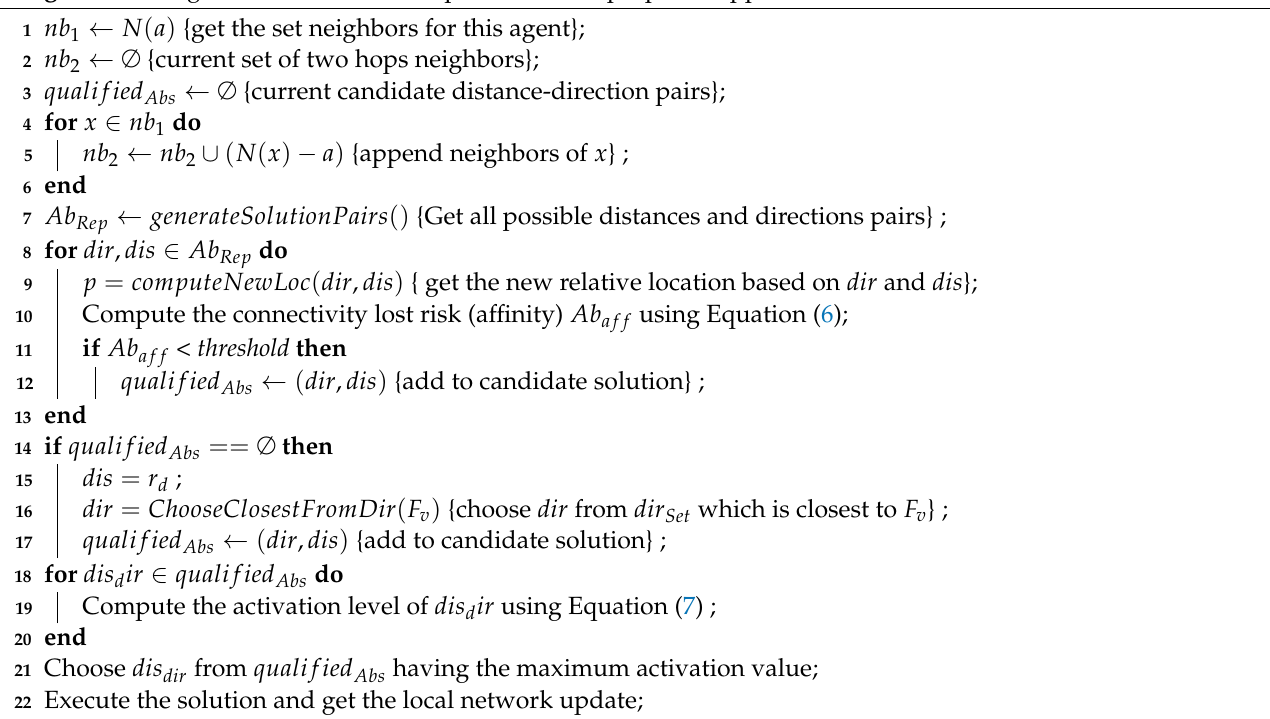
Algorithm 2 Algorithmic Execution of phase II of the proposed